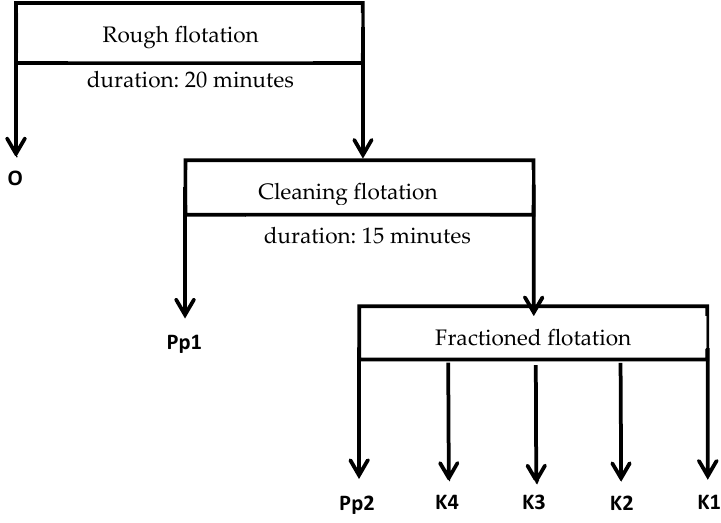
Table 1. Characteristics of flotation process conditions.